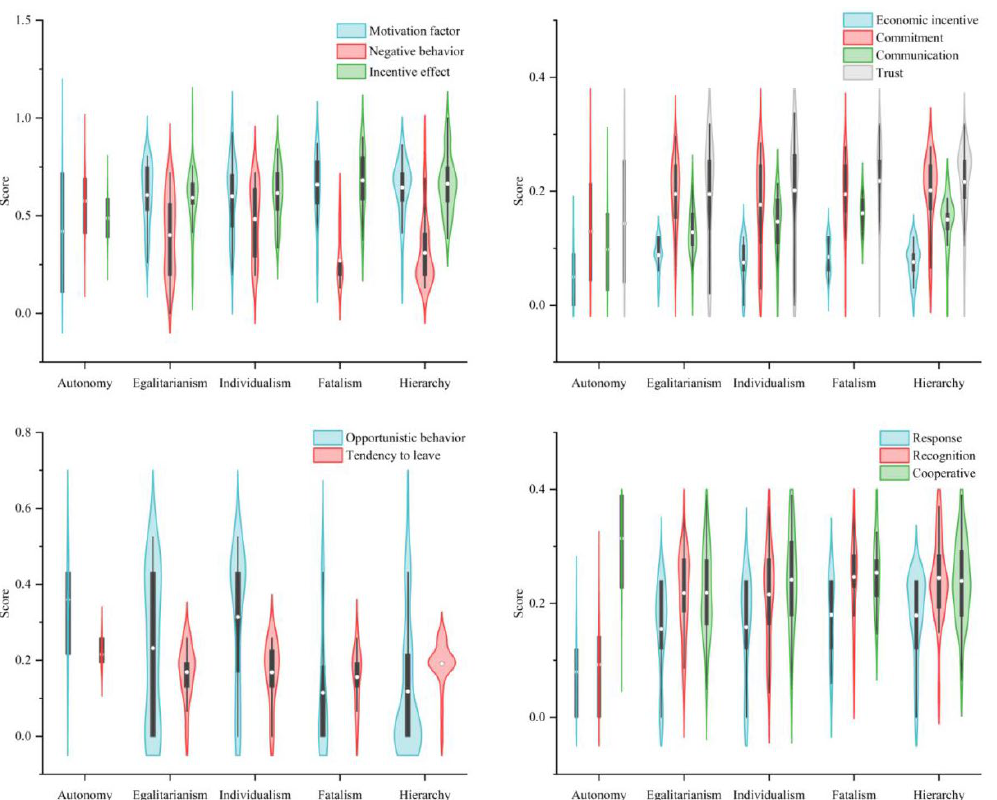
Figure 6. The scores of motivation factor, negative behavior and incentive effect for migrants of different culture types.